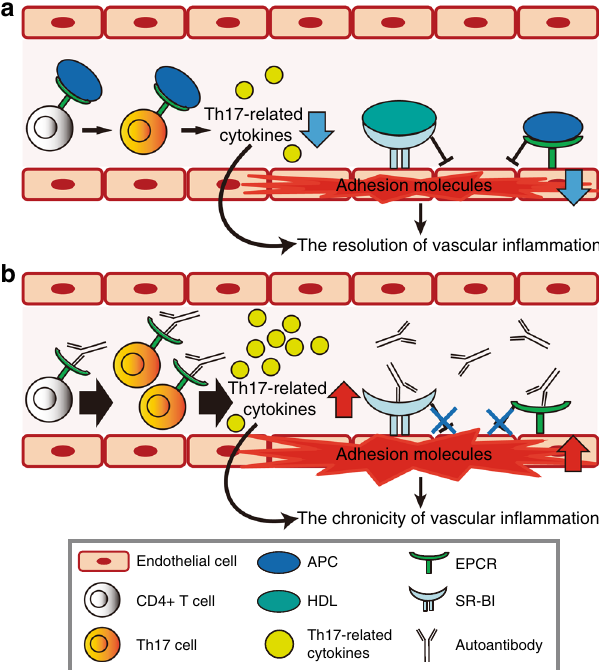
Fig. 7 Proposed model for the pathogenicity of AECAs in Takayasu arteritis. a APC and HDL, the ligand of EPCR and SR-BI, respectively, suppress expression of adhesion molecules in activated endothelial cells. APC also negatively regulates the differentiation of CD4 + T cells expressing EPCR into Th17 cells, and thus inhibits the production of Th17- related cytokines, including IL-17A, IL-17F, IL-21, and IL-22. These mechanisms contribute to the resolution of vascular in fl ammation in normal condition. b Autoantibodies against EPCR or SR-BI block bindings of corresponding ligands to their receptors, which promote expression of adhesion molecules in endothelial cells. In addition, anti-EPCR autoantibodies disrupt the negative regulation of Th17 differentiation by APC and thus amplify Th17-mediated immune response. As a result, autoantibodies in TAK inhibit the spontaneous resolution of activated immune responses in the vessel wall and thus lead to the chronic vascular in fl